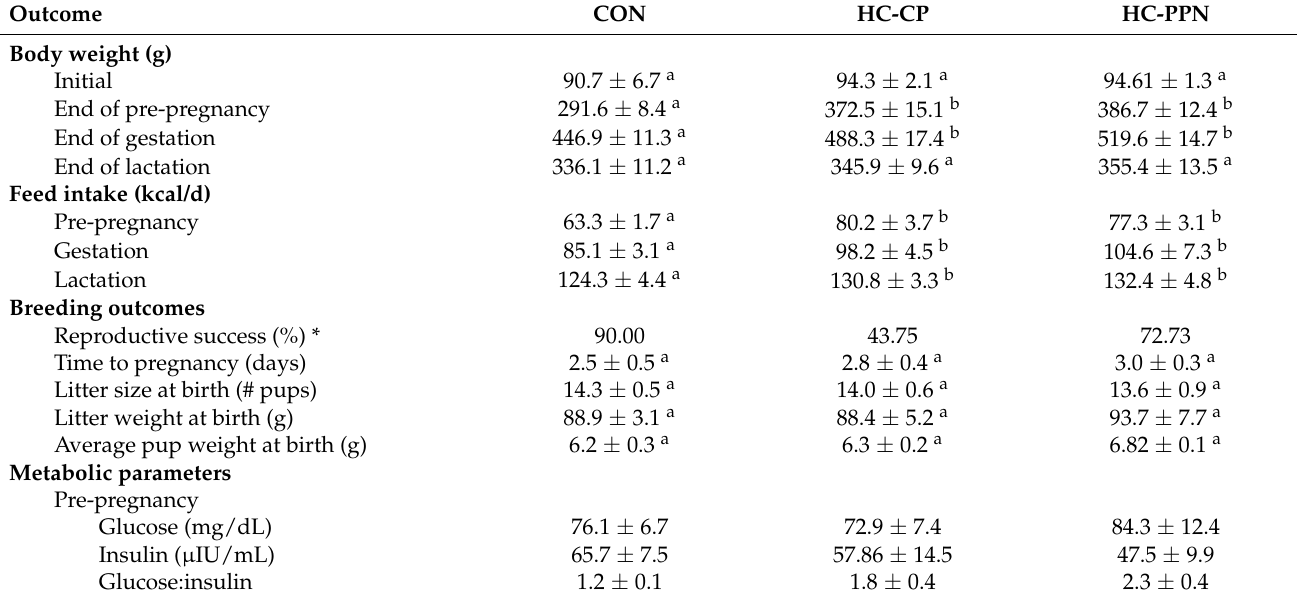
Table 2. Maternal phenotype and pregnancy outcomes throughout the